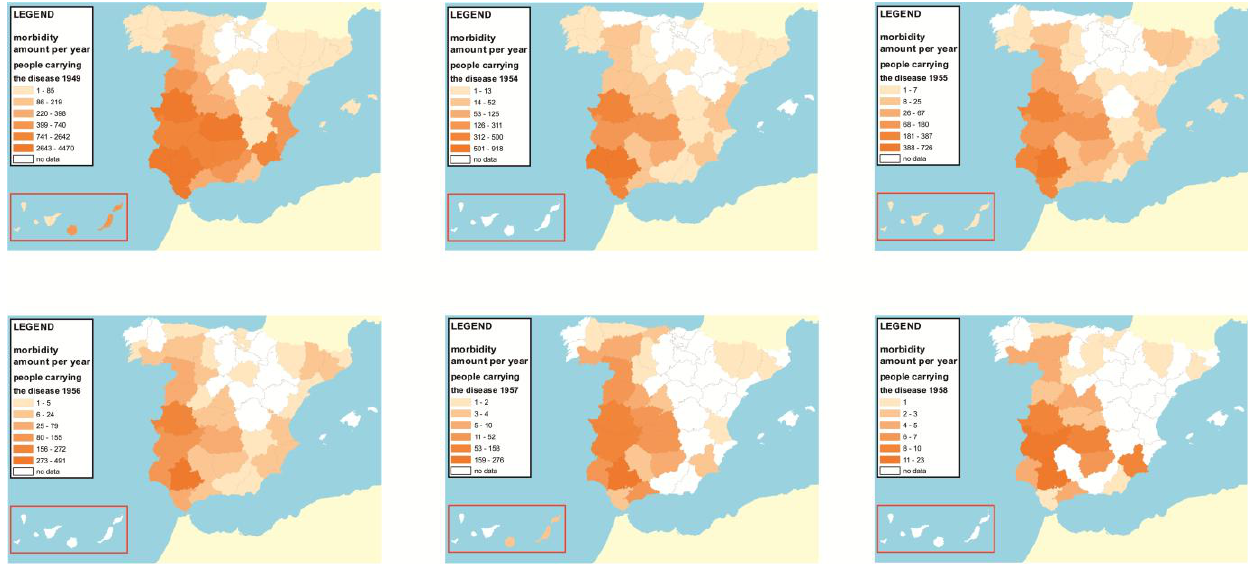
Figure A3. Maps of the distribution of the number of diseased people by malaria in each of the years (1949 and 1954-1961) by